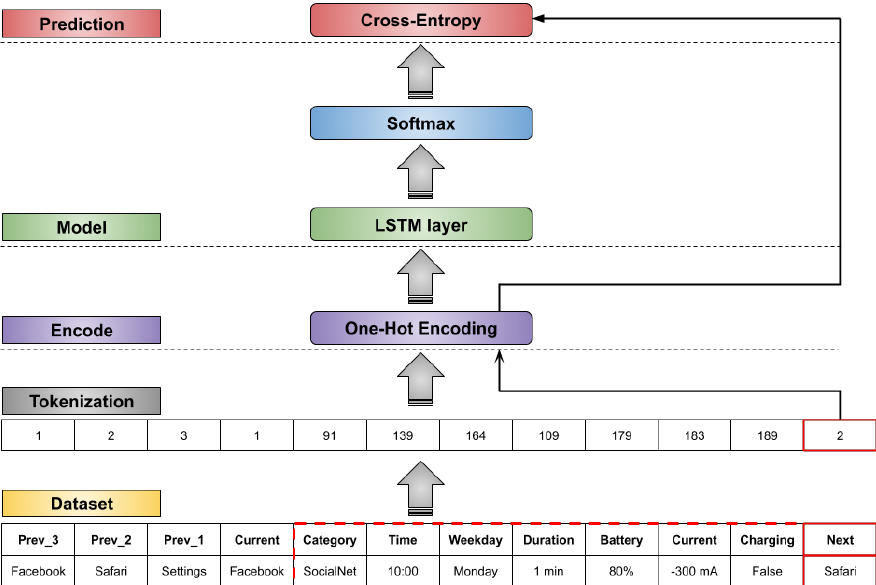
Figure 1. Summary of the Natural App Processing (NAP) approach for app prediction